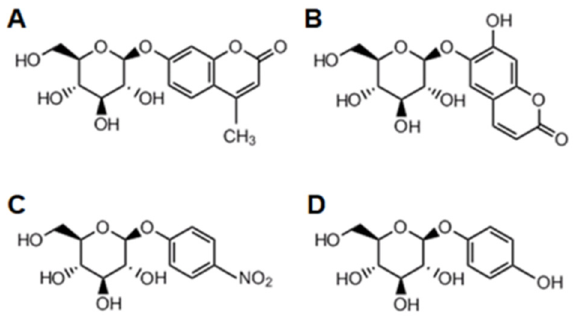
Figure 1. Most common surrogate substrates for the detection of β -glucosidase activities. ( A ) 4-MUG, ( B ) Esculin, ( C ) pNPG, ( D ) Arbutin.